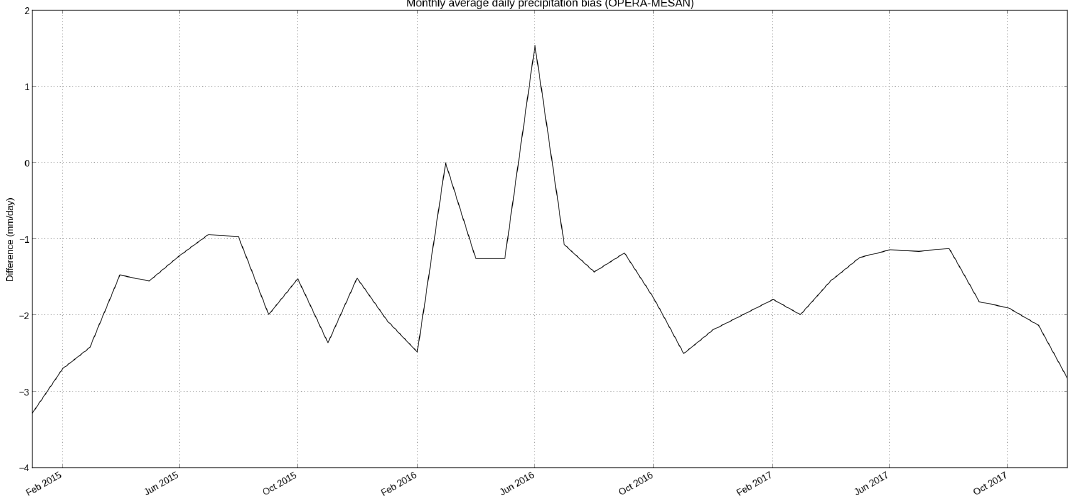
Figure 7. Monthly average daily precipitation intensity bias (OPERA–MESAN) over the OPERA composite